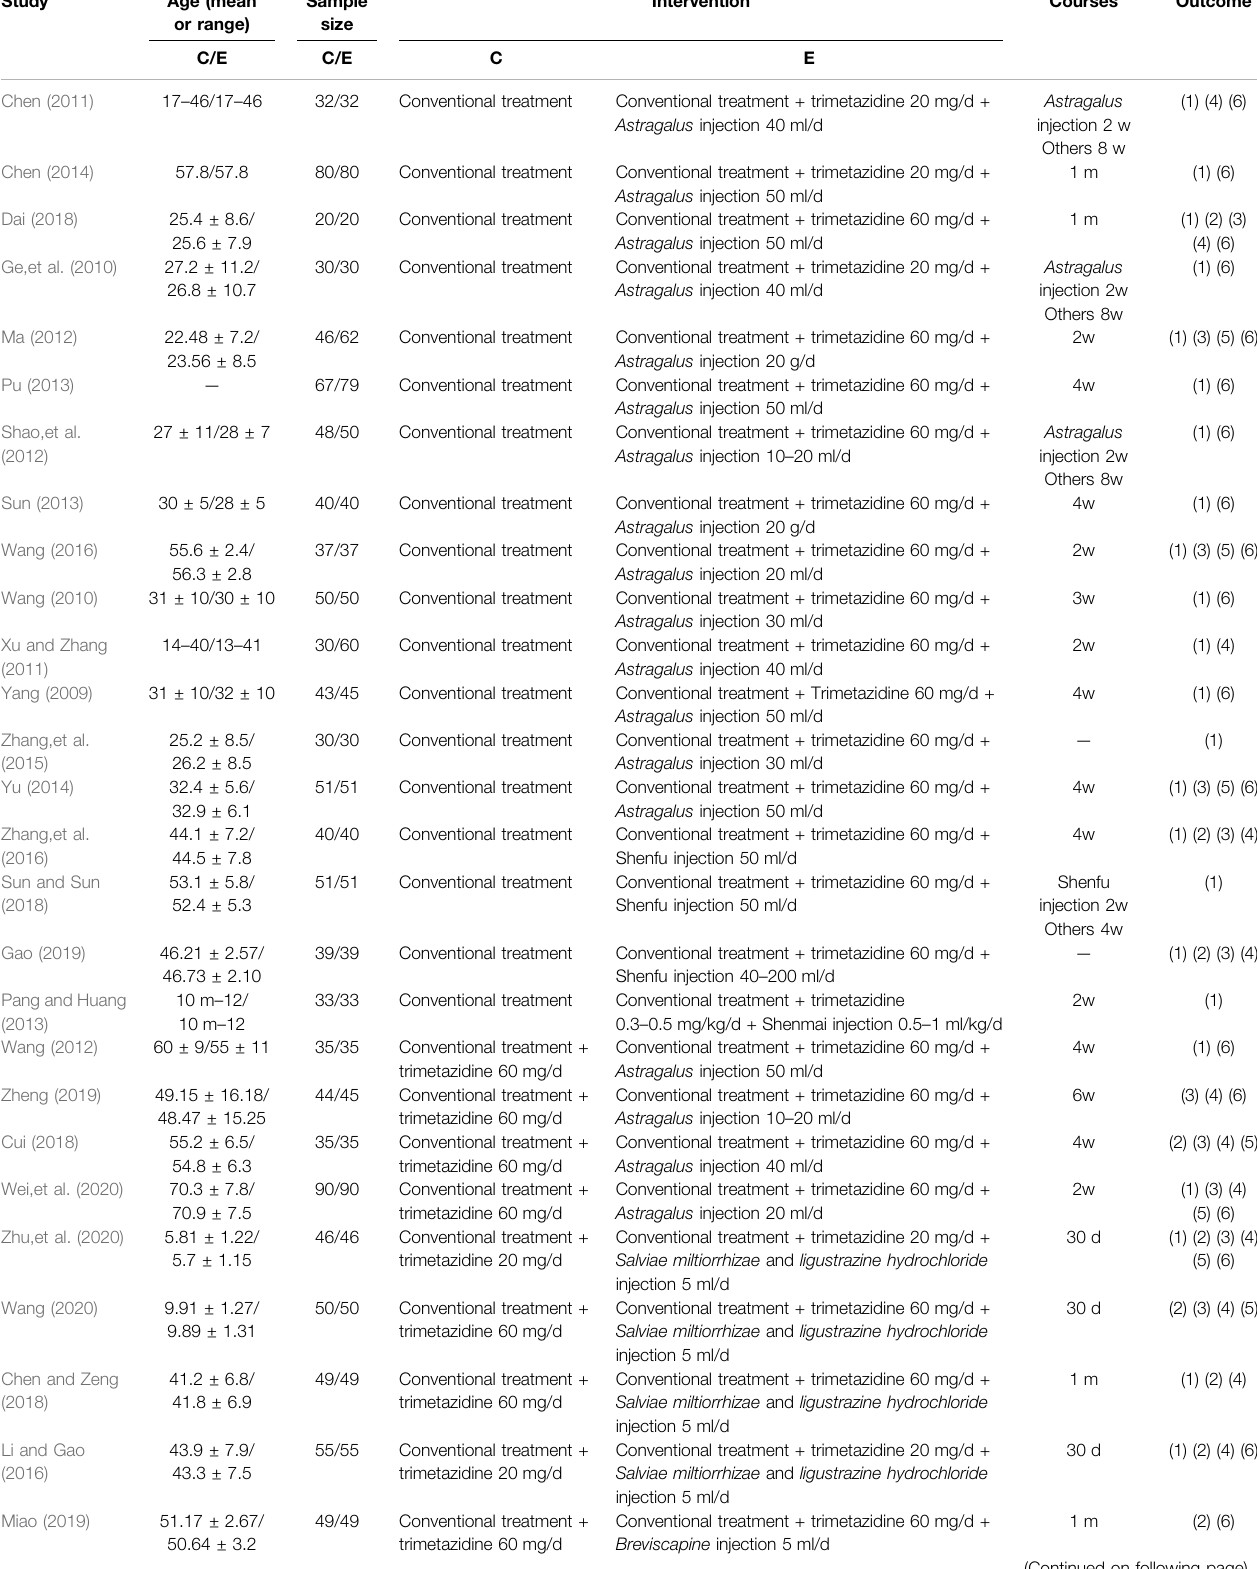
TABLE 1 | Basic characteristics of the included